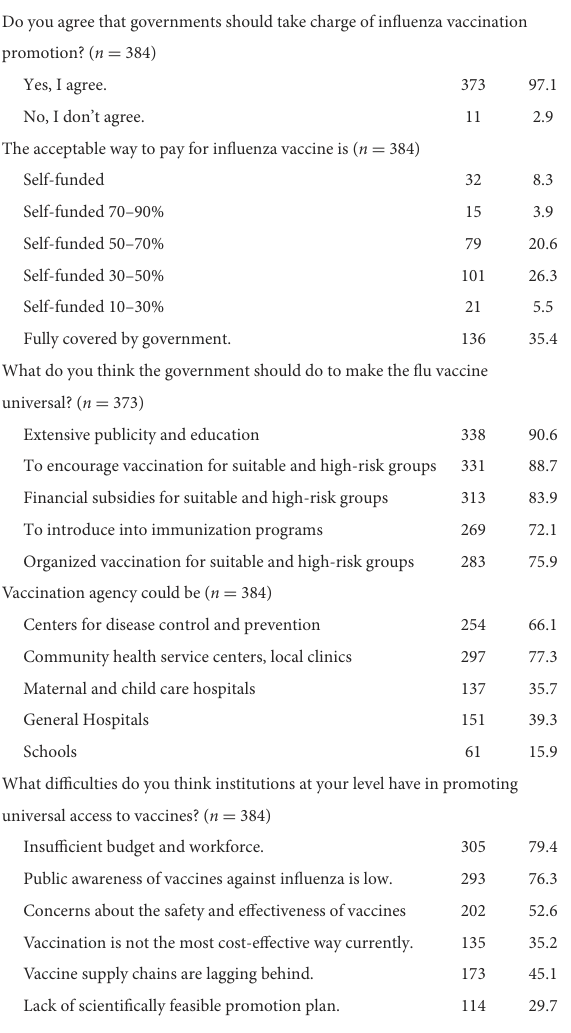
TABLE 4 Health administrators’ opinions toward promoting influenza